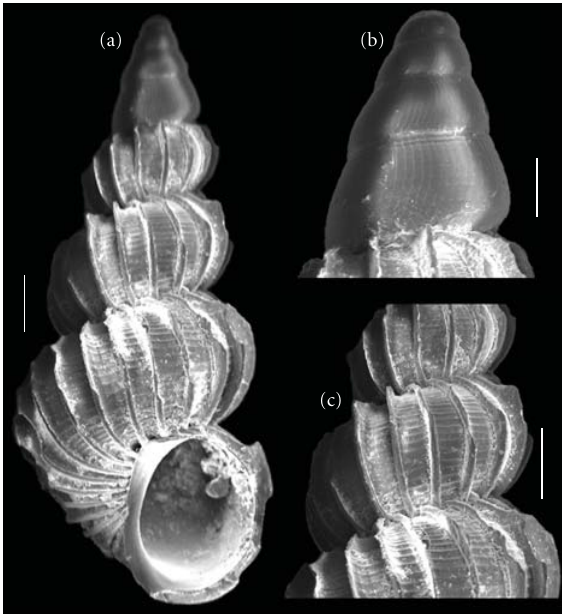
Figure 3: (a–c) Epitonium cf. tiberii (LMUFRPE); (a) ventral view, (b) protoconch and (c) detail of teleoconch ornamentation. Scale bars: (a) and (c) 500 μ m, (b) 200 μ m.